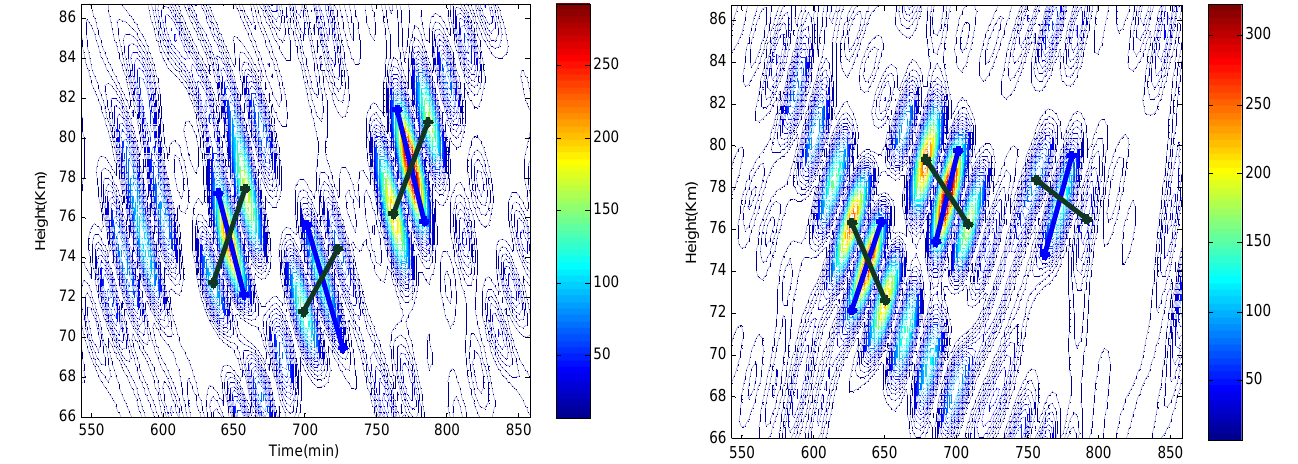
Fig. 1b. A partial height–time plot of (δV ) 2 of upward-phase prop- Fig.1b A partial height-time plot of ( ) 2 V δ of upward-phase propagating gravity agating gravity waves converted from zonal velocity data set ob- served by MU radar at Shigaraki, Japan, on 8 July 1986 (same data waves converted from zonal velocity data set observed by MU radar at set as Fig. Shigaraki Japan on July 8 1986 (same data set of Fig.1a).